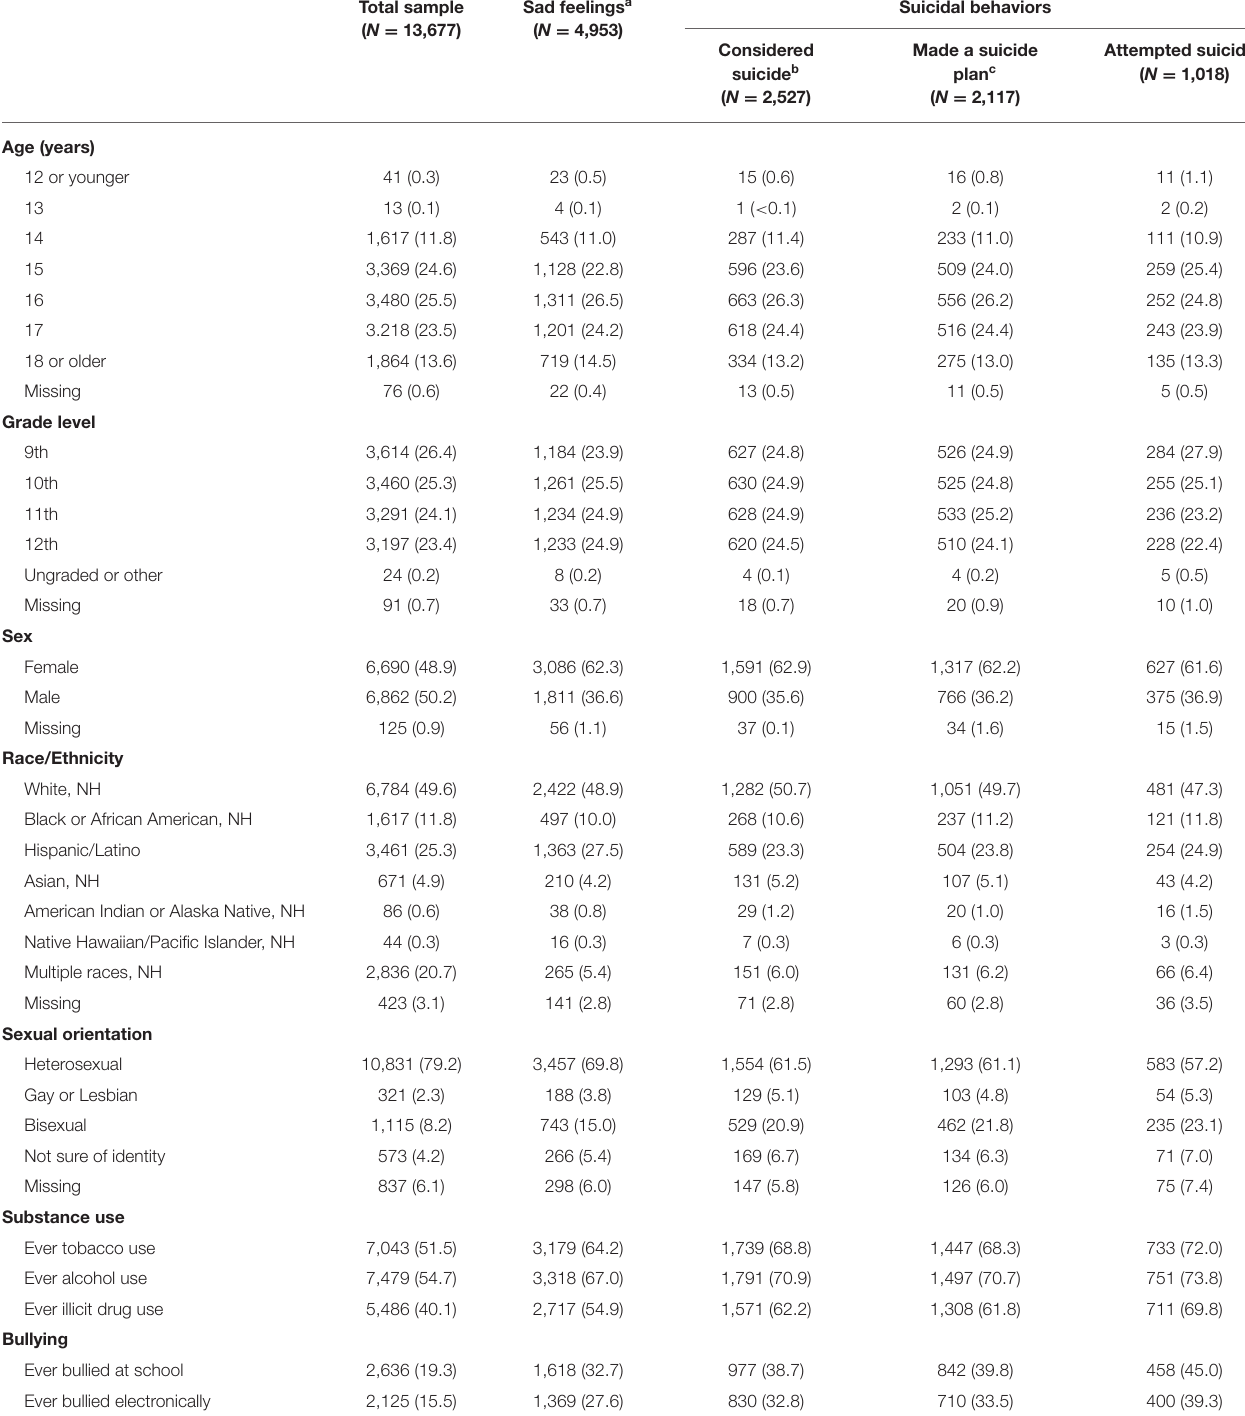
TABLE 1 | Descriptive statistics (weighted counts and percent) of high school students in the YRBS